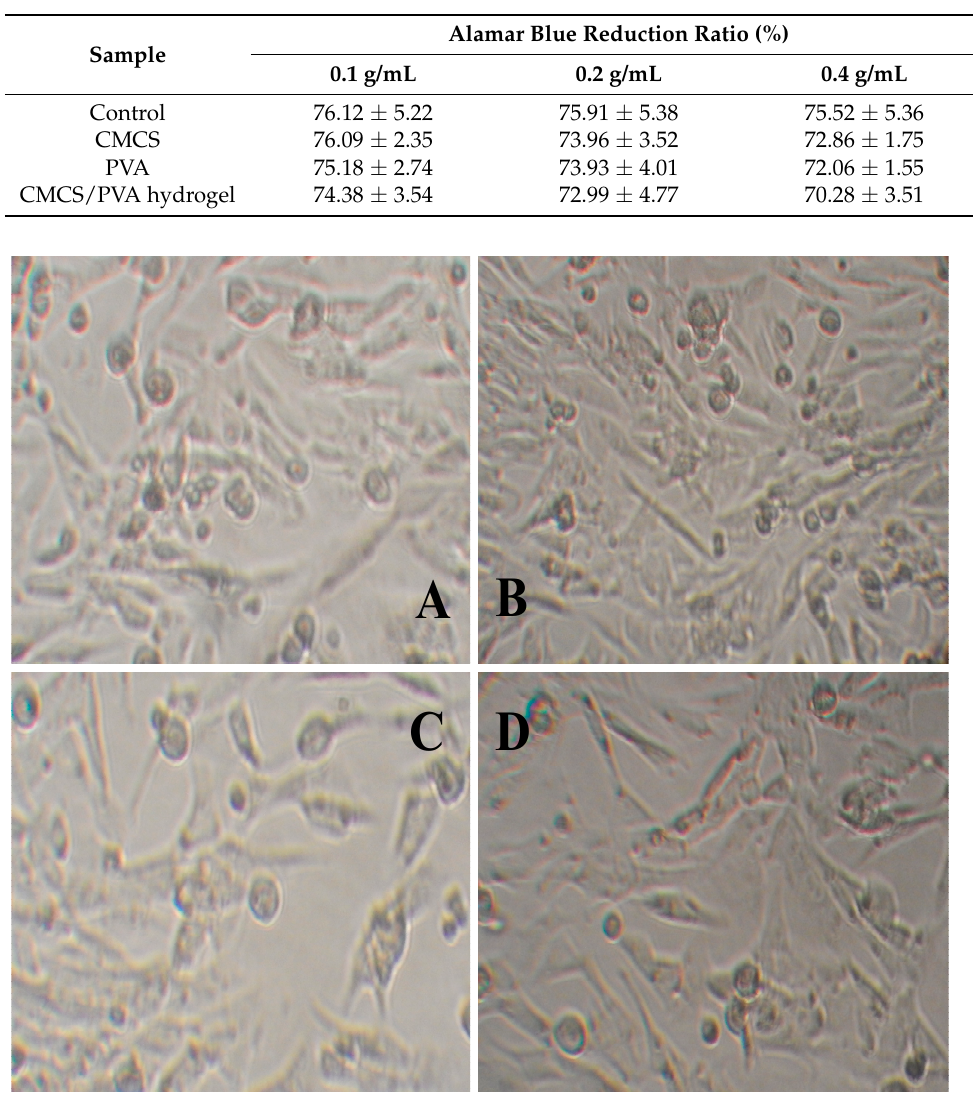
Figure 5. Images of cell growth of L929 with the addition of different hydrogel leaching solutions. ( A , B ) No CMCS/PVA hydrogel leaching solution added; ( A ) before, ( B ) after. ( C , D ) CMCS/PVA hydrogel leaching solution added; ( C ) before, ( D ) after. Table 1. Effect of hydrogel leaching solution concentration on L929 cell activity.